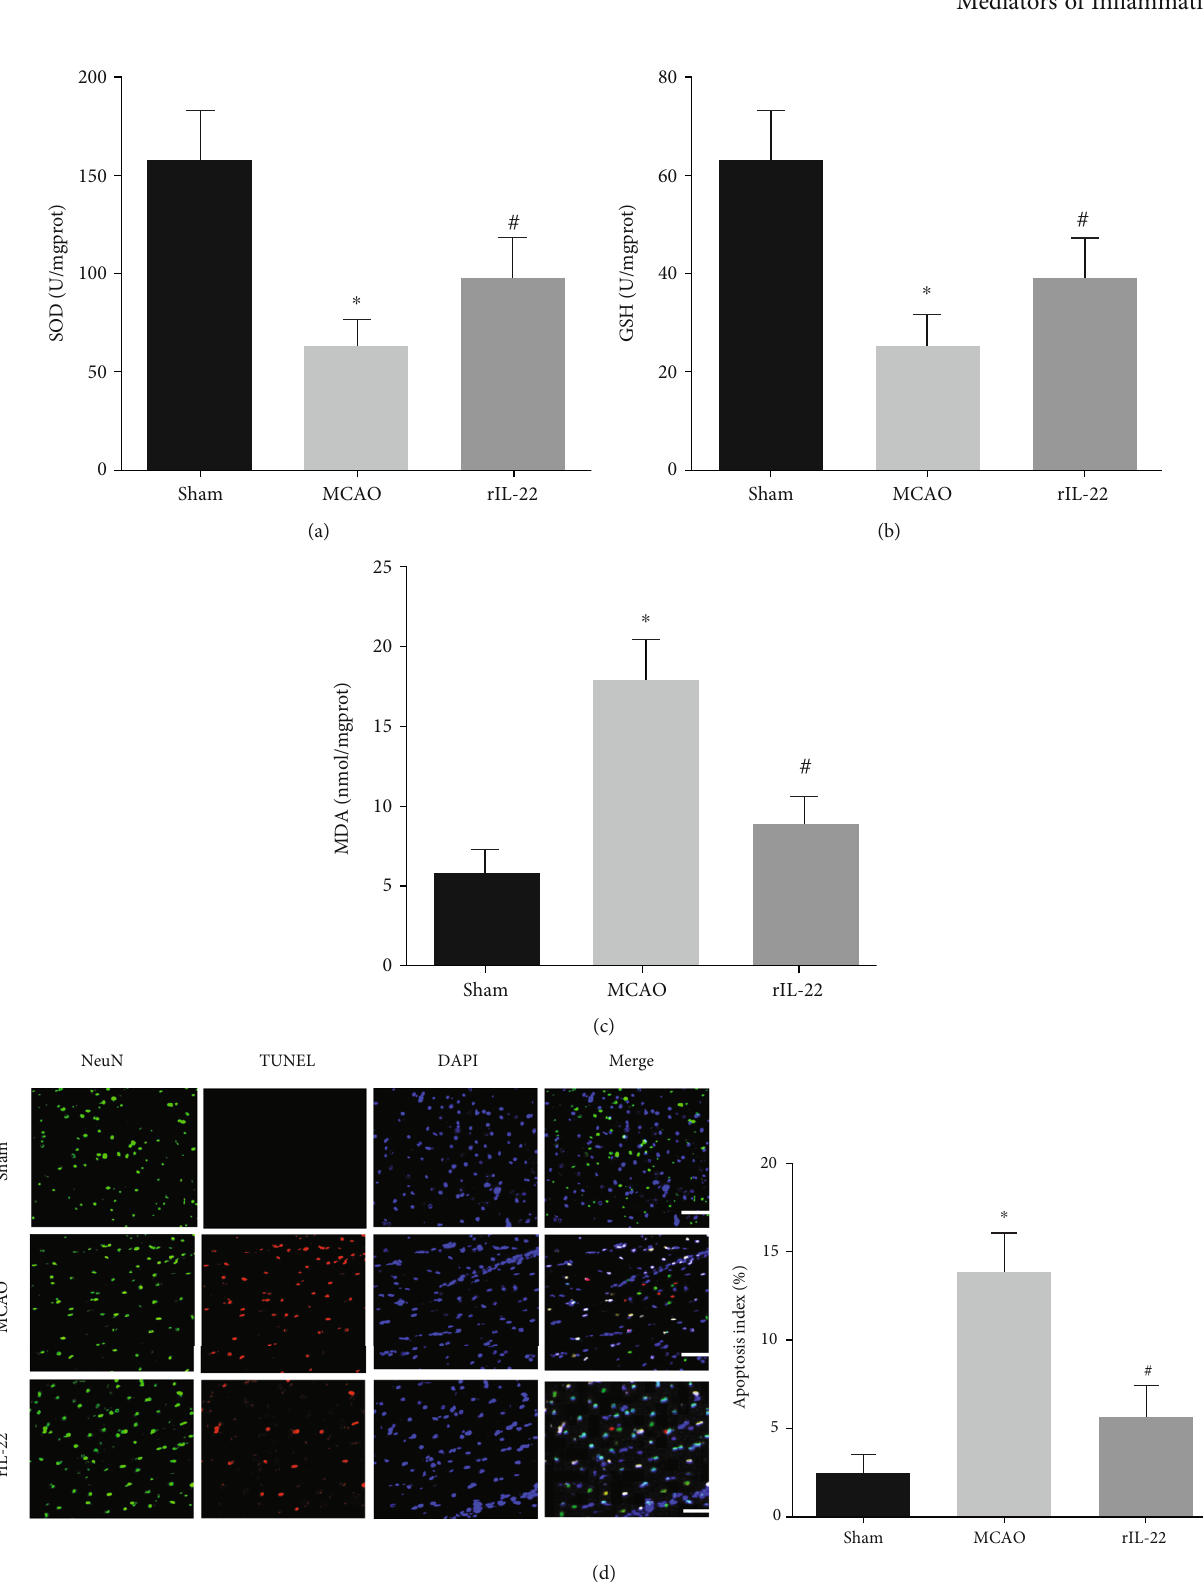
Figure 3: IL-22 treatment attenuated oxidative stress and neuronal apoptosis after cerebral I/R injury. The levels of SOD (a), GSH (b), and MDA (c) were detected in brain tissues ( n = 6 ). (d) Neuronal apoptosis was detected by TUNEL staining combined with immunostaining for NeuN ( n = 5 , scale bar = 75 μ m). ∗ P < 0 : 05 vs. sham group; # P < 0 : 05 vs. MCAO